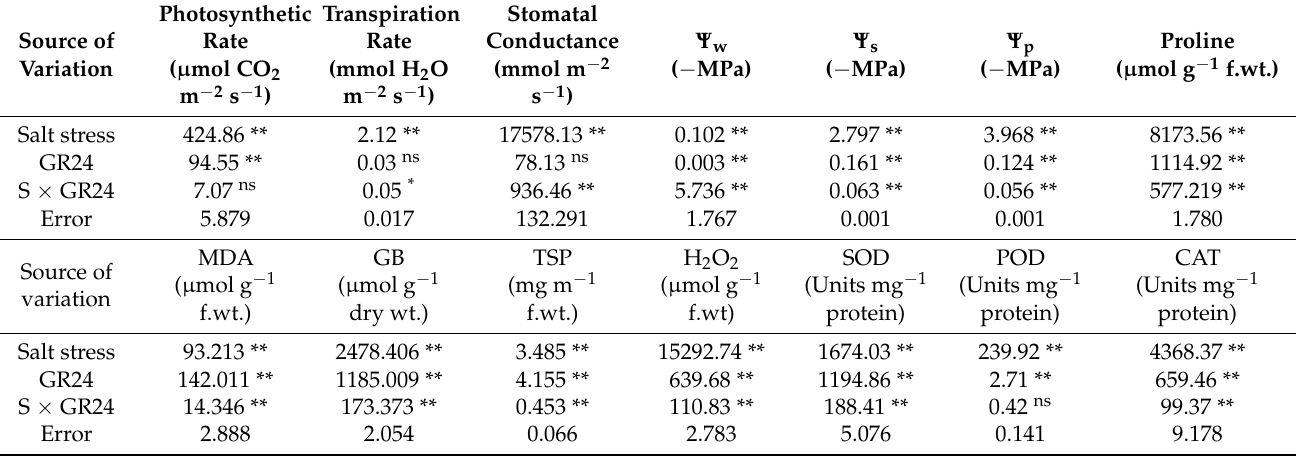
Table 1. Analysis of variance (ANOVA) for different physiological and biochemical characteristics of ornamental sunflower with various GR24 levels (0, 0.001, 0.01 and 0.1 mg L − 1 ) under saline and non-saline